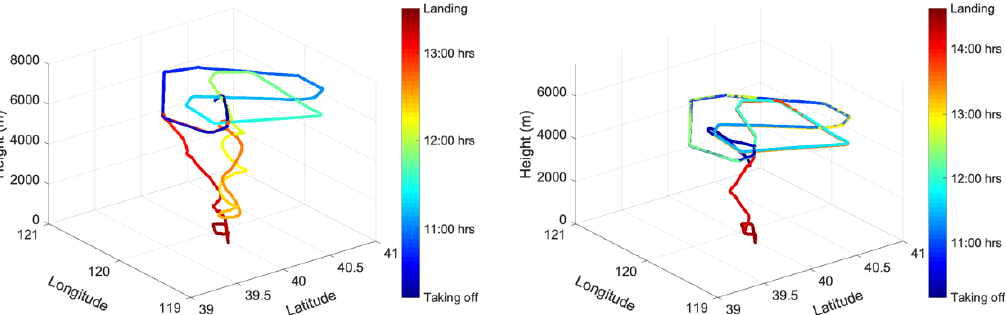
Figure A4. The relative humidity on each observation day during flight.